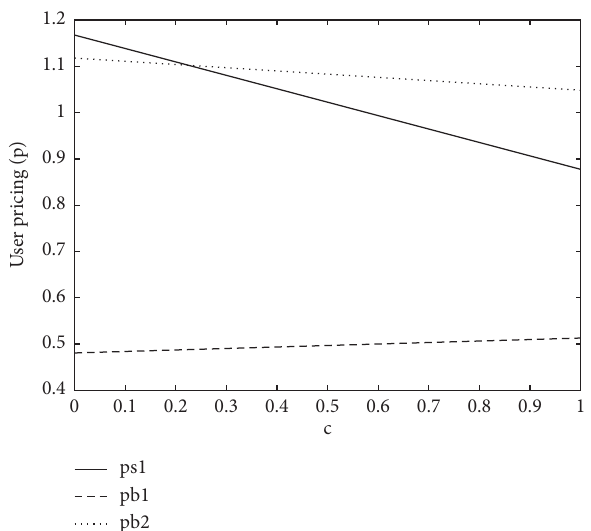
Figure 4: The impact of content production cost on user pricing.